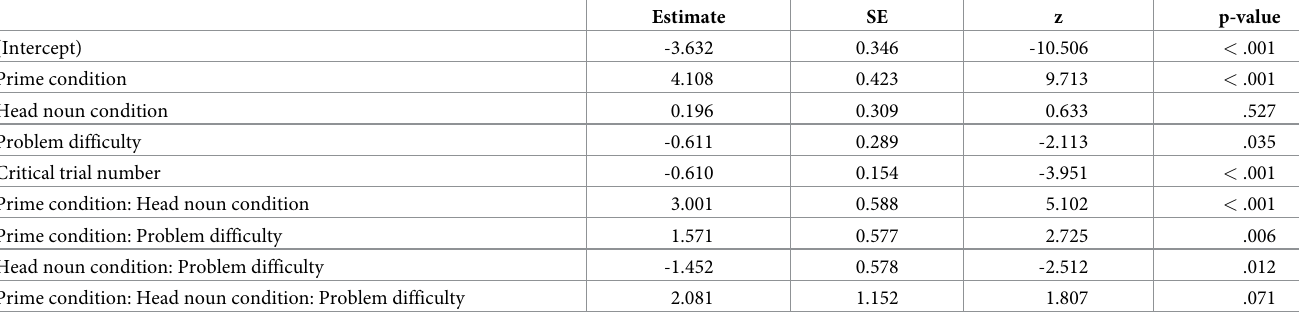
Table 5. Fixed effect estimates (in log odds units), Experiment